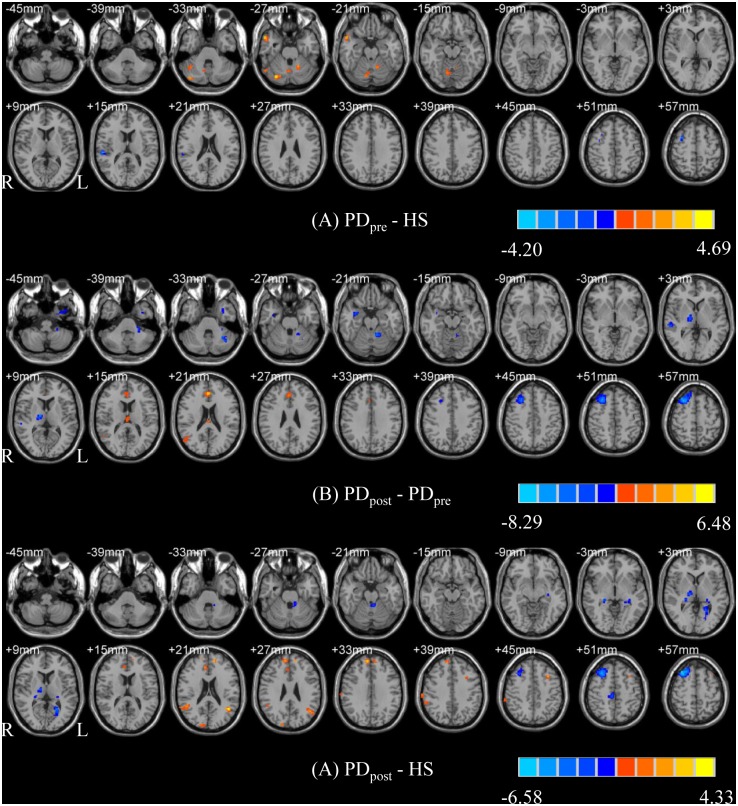
T- statistics maps of rPDpre versus HS (A), rPDpost−rPDpre (B), and rPDpost−HS (C).T-score bar: hot and cold colors indicate ReHo increases and decreases, respectively. rPD: patients receiving right-side VIM thalamotomy.